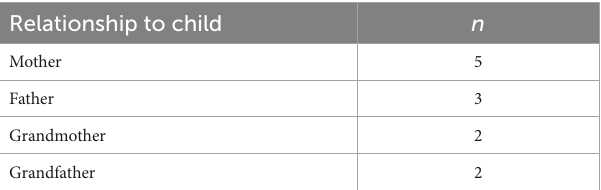
TABLE 1 Primary caregivers of young children with a disability in rural Zimbabwe ( n =